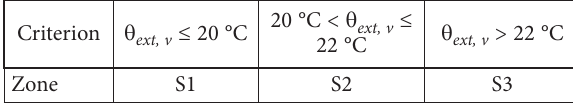
Table 3. Criterion for determining the summer climate zone